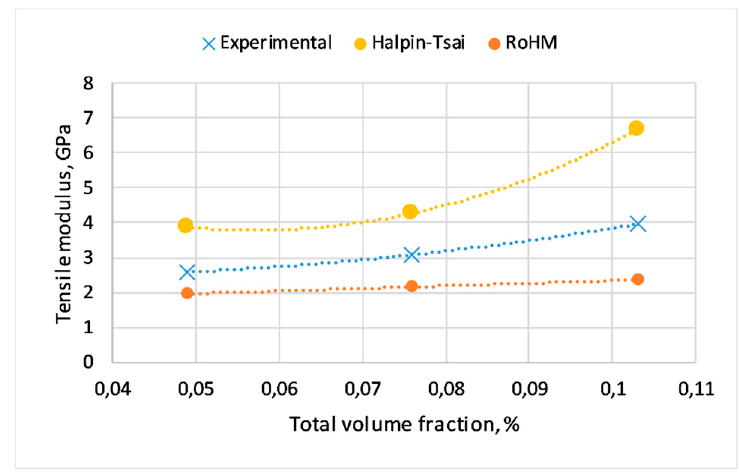
Figure 4. Comparison of modulus experimental results with RoHM and Halpin–Tsai equations.